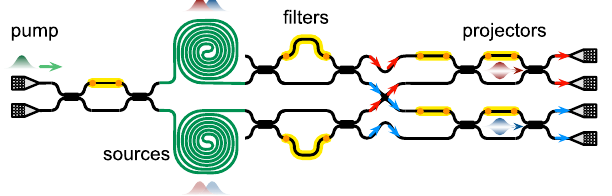
Figure 4. Schematic of an integrated silicon-photonics quantum device. The quantum device is capable of generating, manipulating and analyzing maximally path-entangled states. The device is fabricated on the silicon-on-insulator platform. Lines are silicon nanophotonic waveguides with the size of 450 nm yellow parts are thermo-optic phase shifters that can be precisely controlled in experiment. A continuous wave laser light (at the wavelength of 1550.12 nm) was used to pump two photon-pair sources, producing a pair of path-entangled photons via the spontaneous four-wave mixing (sFWM) process. The entangled photons were locally manipulated and analyzed by Alice (signal photon at 1545.31 nm) and Bob (idler photon at 1554.91 nm), respectively, which were implemented by the terminate Mach-Zehnder interferometers (MZIs). The two photons are measured by two superconducting nanowire single-photon detectors (SNSPDs), and their coincidence were recorded by a time tagger.